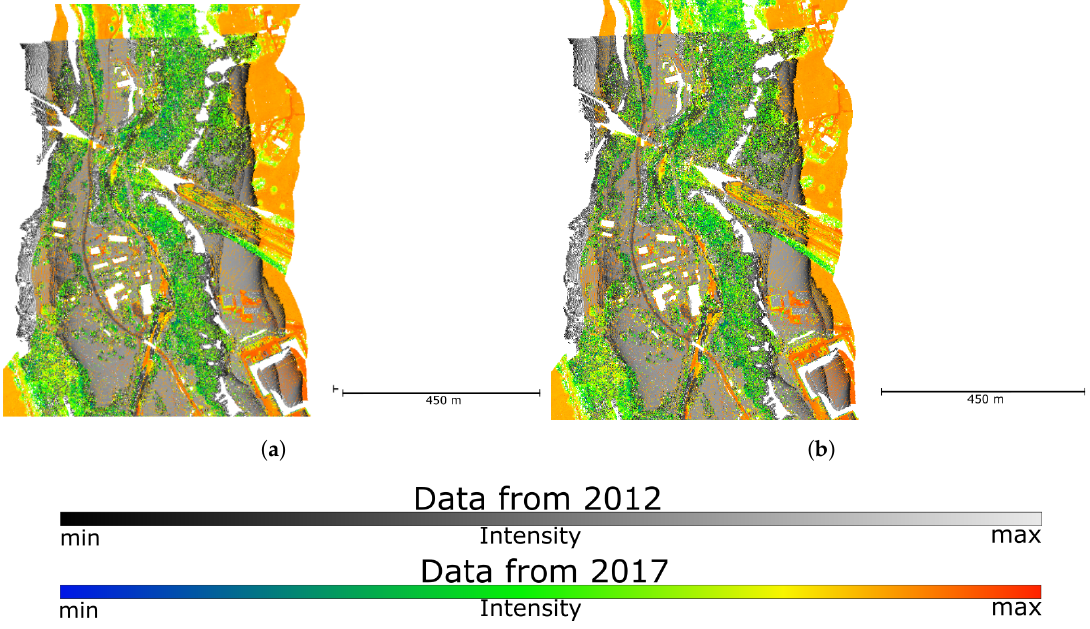
Figure 10. Comparison of the registration results using ICP and the proposed approach shown on the second scene. ( a ) Result of ICP. ( b ) Result of the proposed method. Shown data are the date of the whole flight strip downsampled to 1 m GSD.